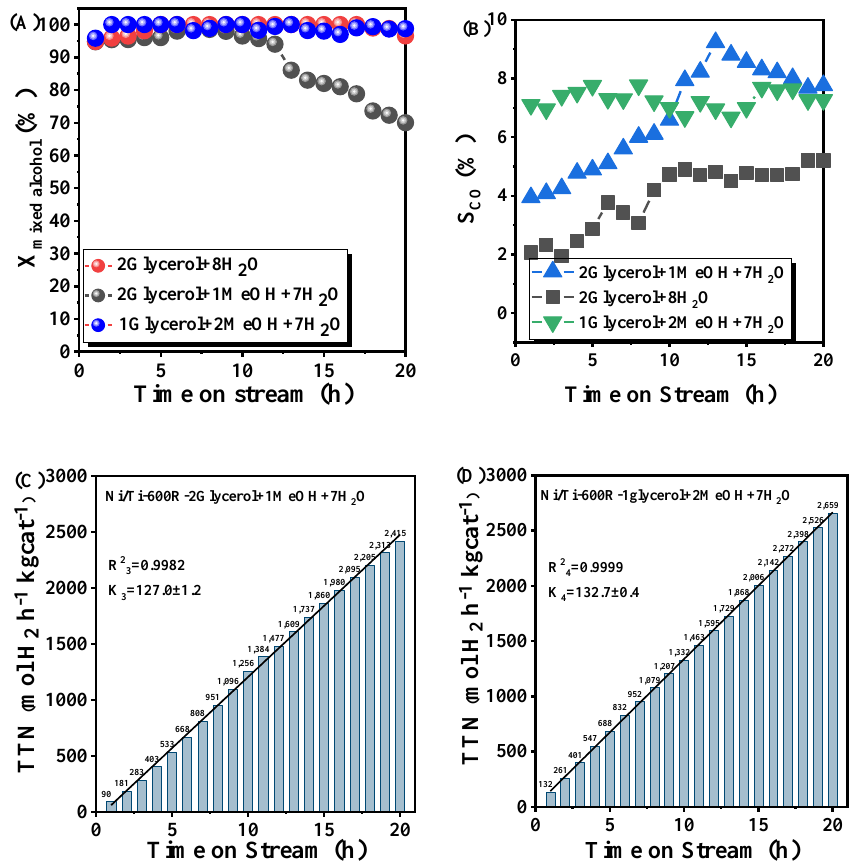
Figure 8. The conversion rate ( A ), CO selectivity ( B ) and hydrogen production stability ( C ), ( D ) of mixed alcohol feeds on Ni/Ti-600R catalyst in 20 h.